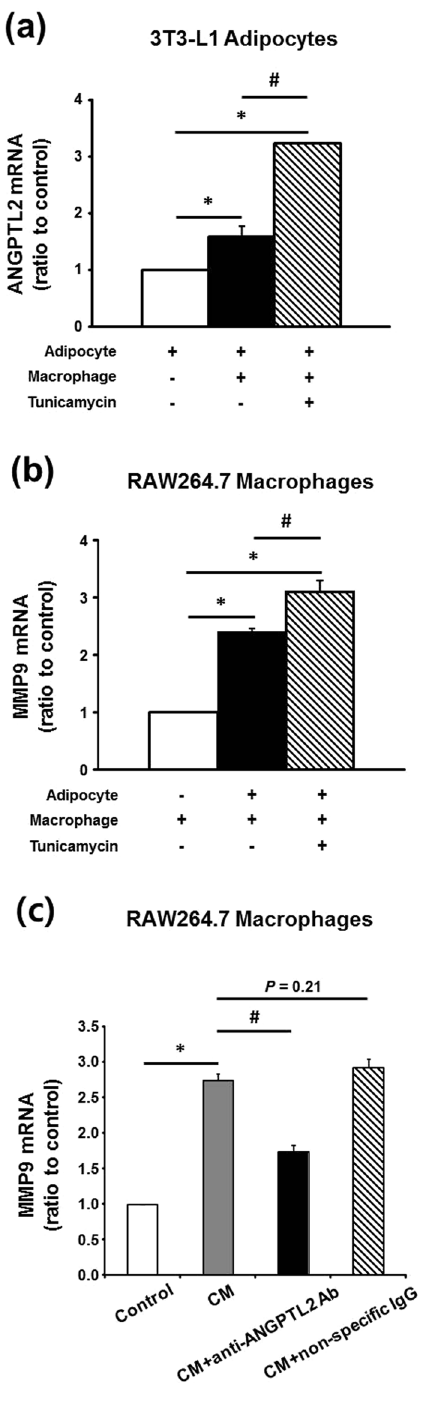
Figure 5. Induction of ANGPTL2 and MMP9 mRNA expression by co-culture of adipocytes and macrophages and reduction of MMP9 mRNA expression by ANGPTL2 blockade. ( a , b ) Differentiated 3T3-L1 adipocytes were co-cultured for 24 hours with RAW264.7 macrophages using transwell system. Measurement of ANGPTL2 mRNA expression in differentiated adipocytes ( a ) and MMP9 mRNA expression in macrophages ( b ) was performed by qPCR (n = 3). Incubation with tunicamycin (2 μ g/mL) was conserved in both of cells for 16 hours. * p < 0.05 vs . each of cells alone, # p < 0.05 vs . co-cultured cells. The data were analyzed by ANOVA with Tukey test. ( c ) Induction of MMP9 mRNA by adipocyte-conditioned media (CM) and partially reduction of MMP9 mRNA expression by anti-ANGPTL2 antibody (4 μ g/mL). RAW264.7 macrophages were incubated for 16 hours in the presence of CM, CM + anti-ANGPTL2 Ab, or CD + non-specific IgG (n = 3). * p < 0.05 vs . control, # p < 0.05 vs . CM by ANOVA with Tukey